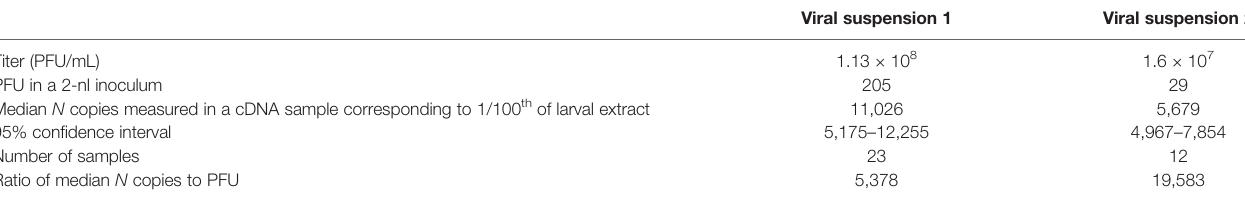
TABLE 1 | Initial sense N copy